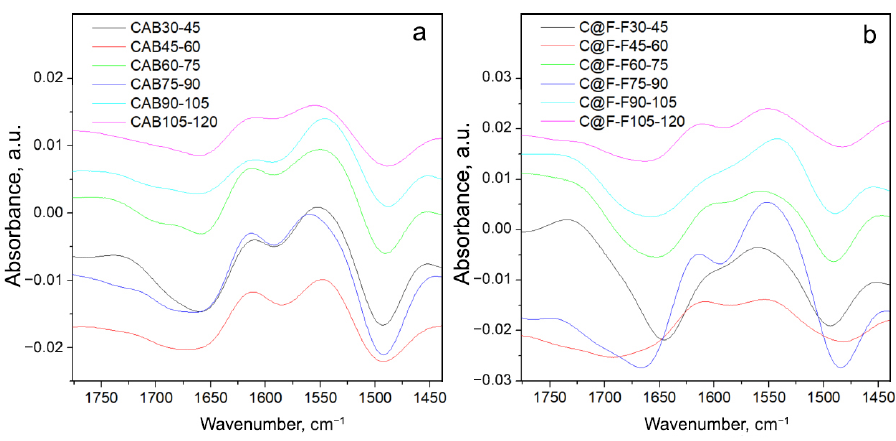
Figure 6. Difference spectra for CAB ( a ) and C@F-F ( b ). Each spectrum is obtained as the difference between the spectrum obtained at lower and the nearest higher